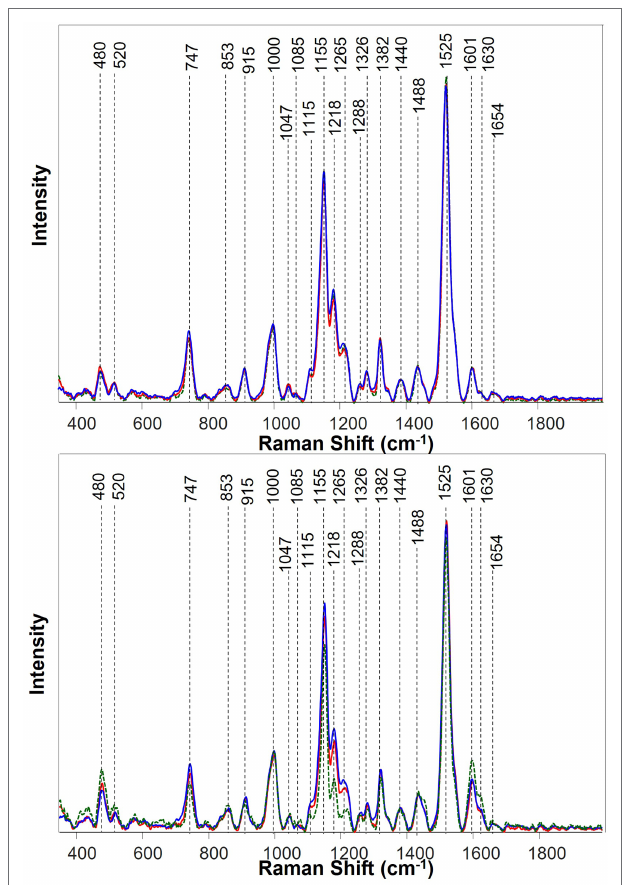
FIGURE 3 | Averaged Raman spectra of banana leaves at the early infection at 47 days after inoculation (DAI; top) and asymptomatic plants at 75 DAI (bottom). Three treatment groups were color-coded as uninoculated and well-watered control plants (red), FOC-inoculated and well-watered plants (blue), and uninoculated and water-deficient plants (green).